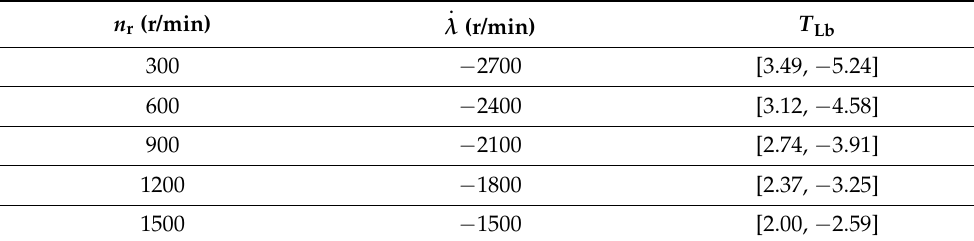
Table 2. The boundaries of load torque at ψ (cid:48) cr = 0.7